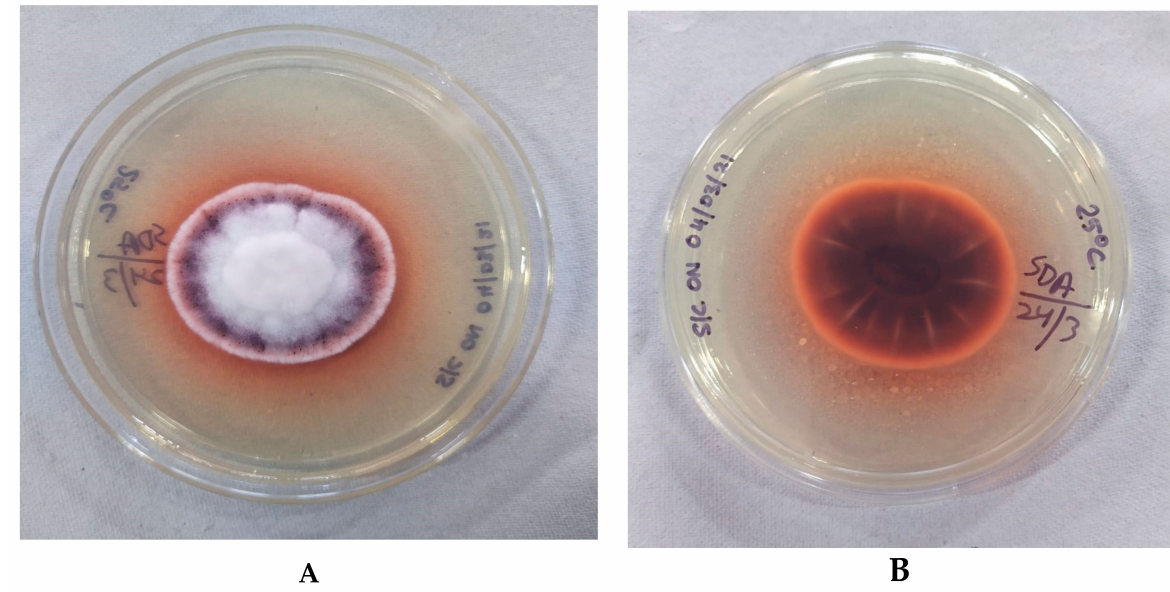
Figure 2. Macroscopic appearance of Fusarium lichenicola at 25 ◦ C after 4 days of incubation. ( A ) Obverse showing white, short aerial hyphae with a pinkish-red rim; ( B ) reverse brown with a diffusible chestnut brown-red